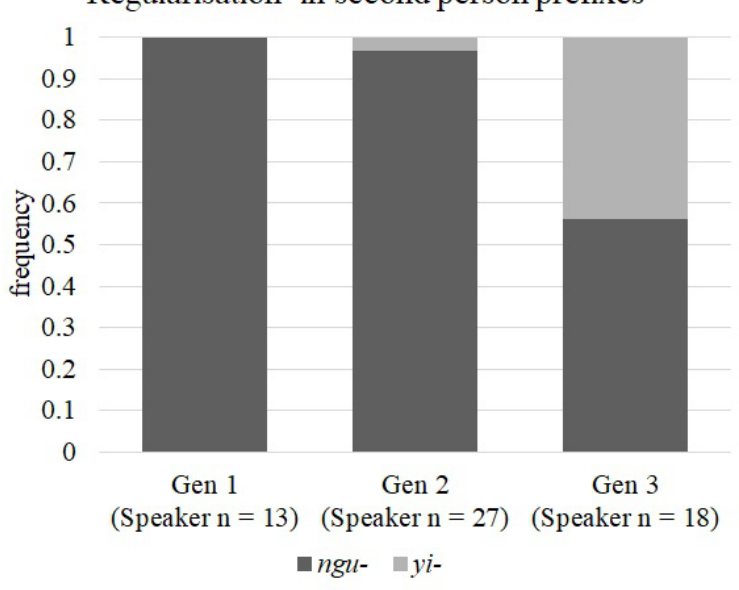
Figure 3. Second person prefix regularisation rates of three generational groups in corpus data. Overall, 12 speakers were recorded regularising: 11 from Gen 3 and 1 from Gen 2.